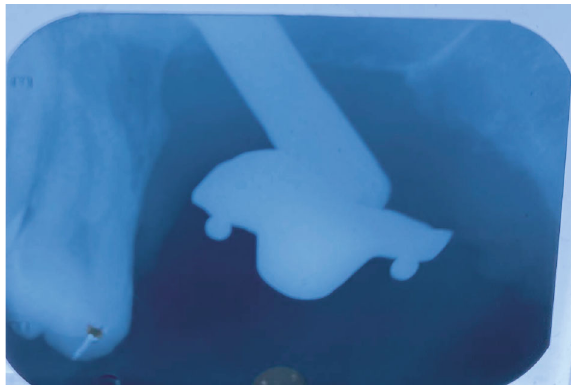
Figure 6: IOPA of O-ball attachment secured with prosthetic screw over multiunit